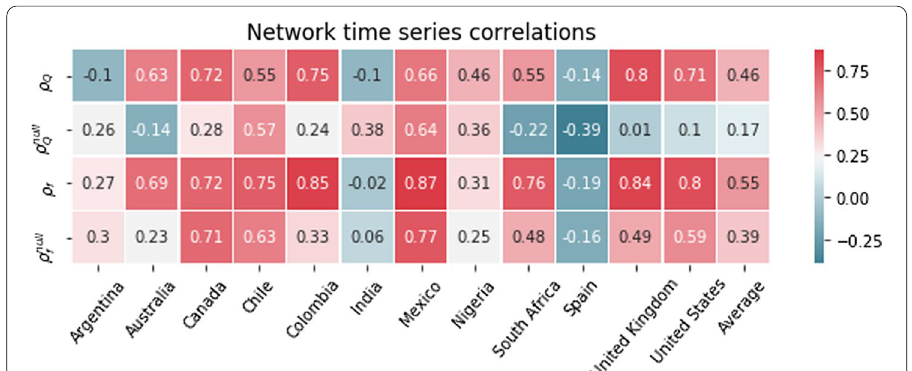
Fig. 5 Correlation coefficients between the log of daily national death counts and the network measures Q LIWC and f Death [see Eqs. (6) and (7) respectively]. We indicate null model counterparts with superscripts “null” (see main text for